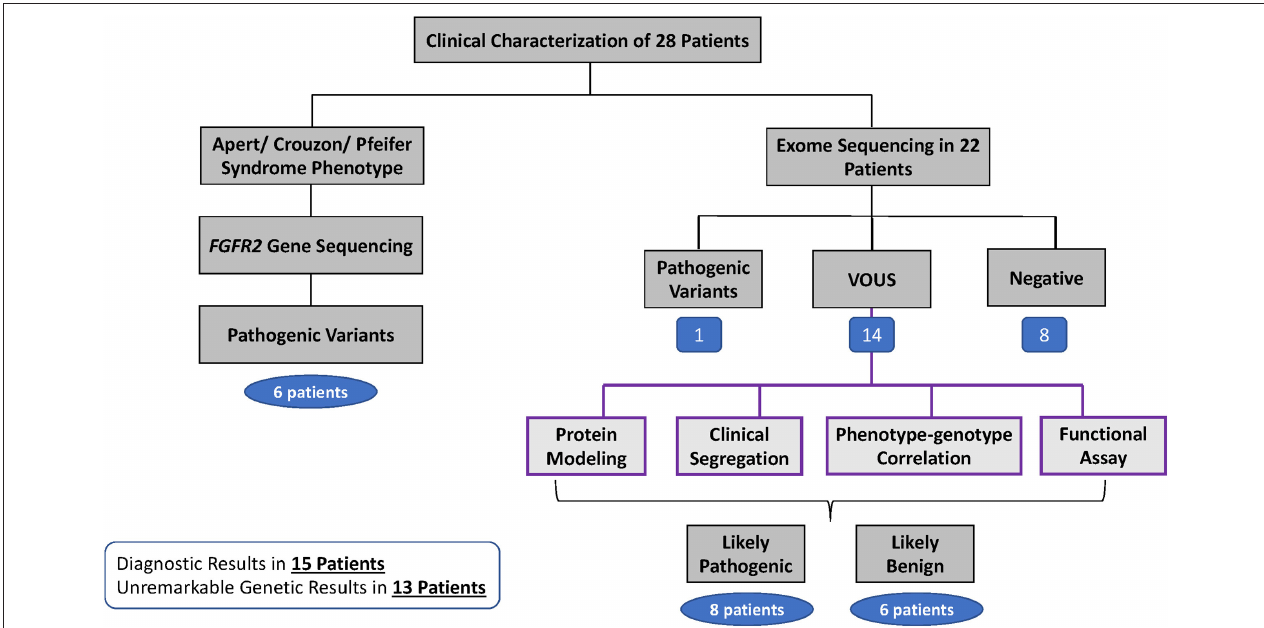
FIGURE 5 | Clinical and Genetic workflow and result of 28